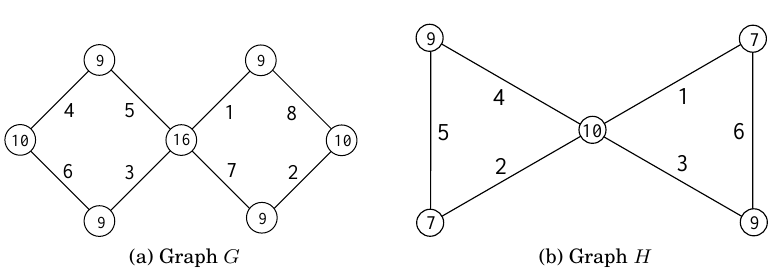
Figure 1: Local antimagic 3 -colorings of graphs G and H